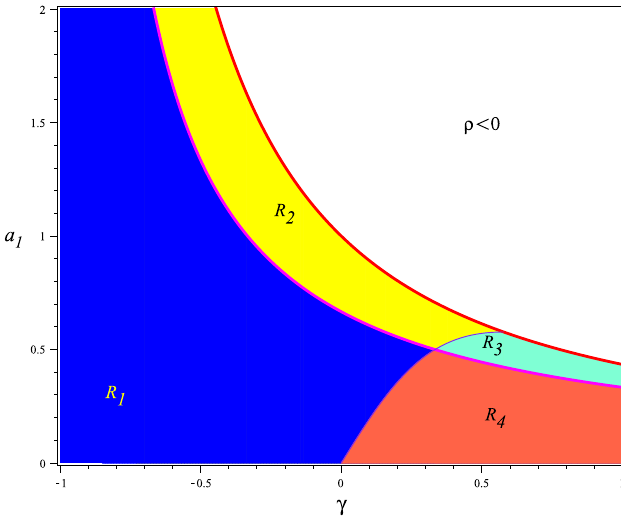
Figure 1. FRW model described by: eff T µν = T µν + ( φ ) T µν + ( V ) T µν . Plot of the region R (colored area), where the energy density is positive, γ ∈ ( − 1,1 ] and a 1 ∈ ( 0,2 ] . See (73) for an explanation of the subregions R i .